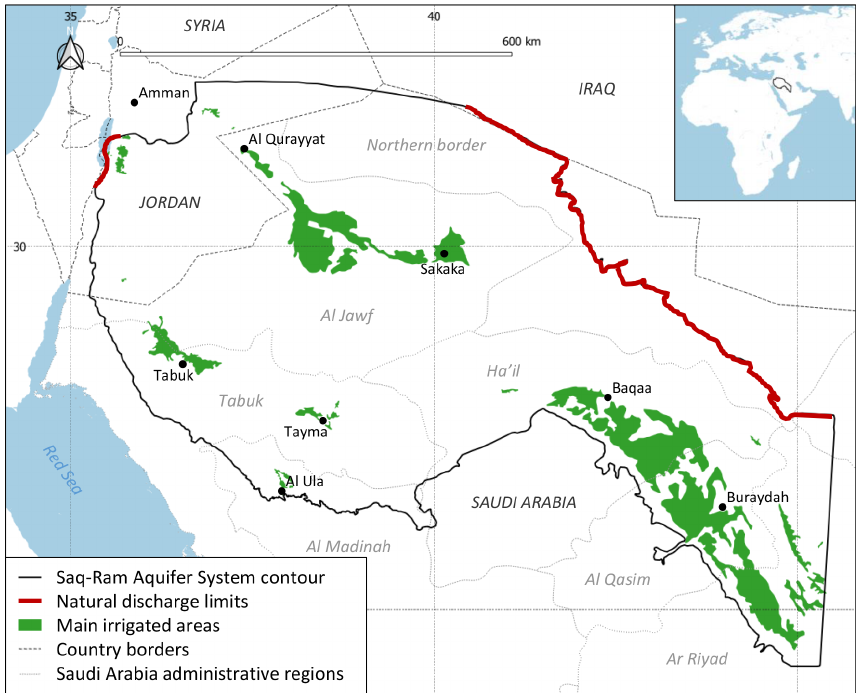
Figure 1. Context map of the Saq–Ram Aquifer System (WGS84 coordinates shown by straight dotted lines every 5 ◦ (Shorelines and coun- try borders extracted from Wessel and Smith, 1996; Administrative regions extracted from https://www.gadm.org/, last access: 10 Novem- ber